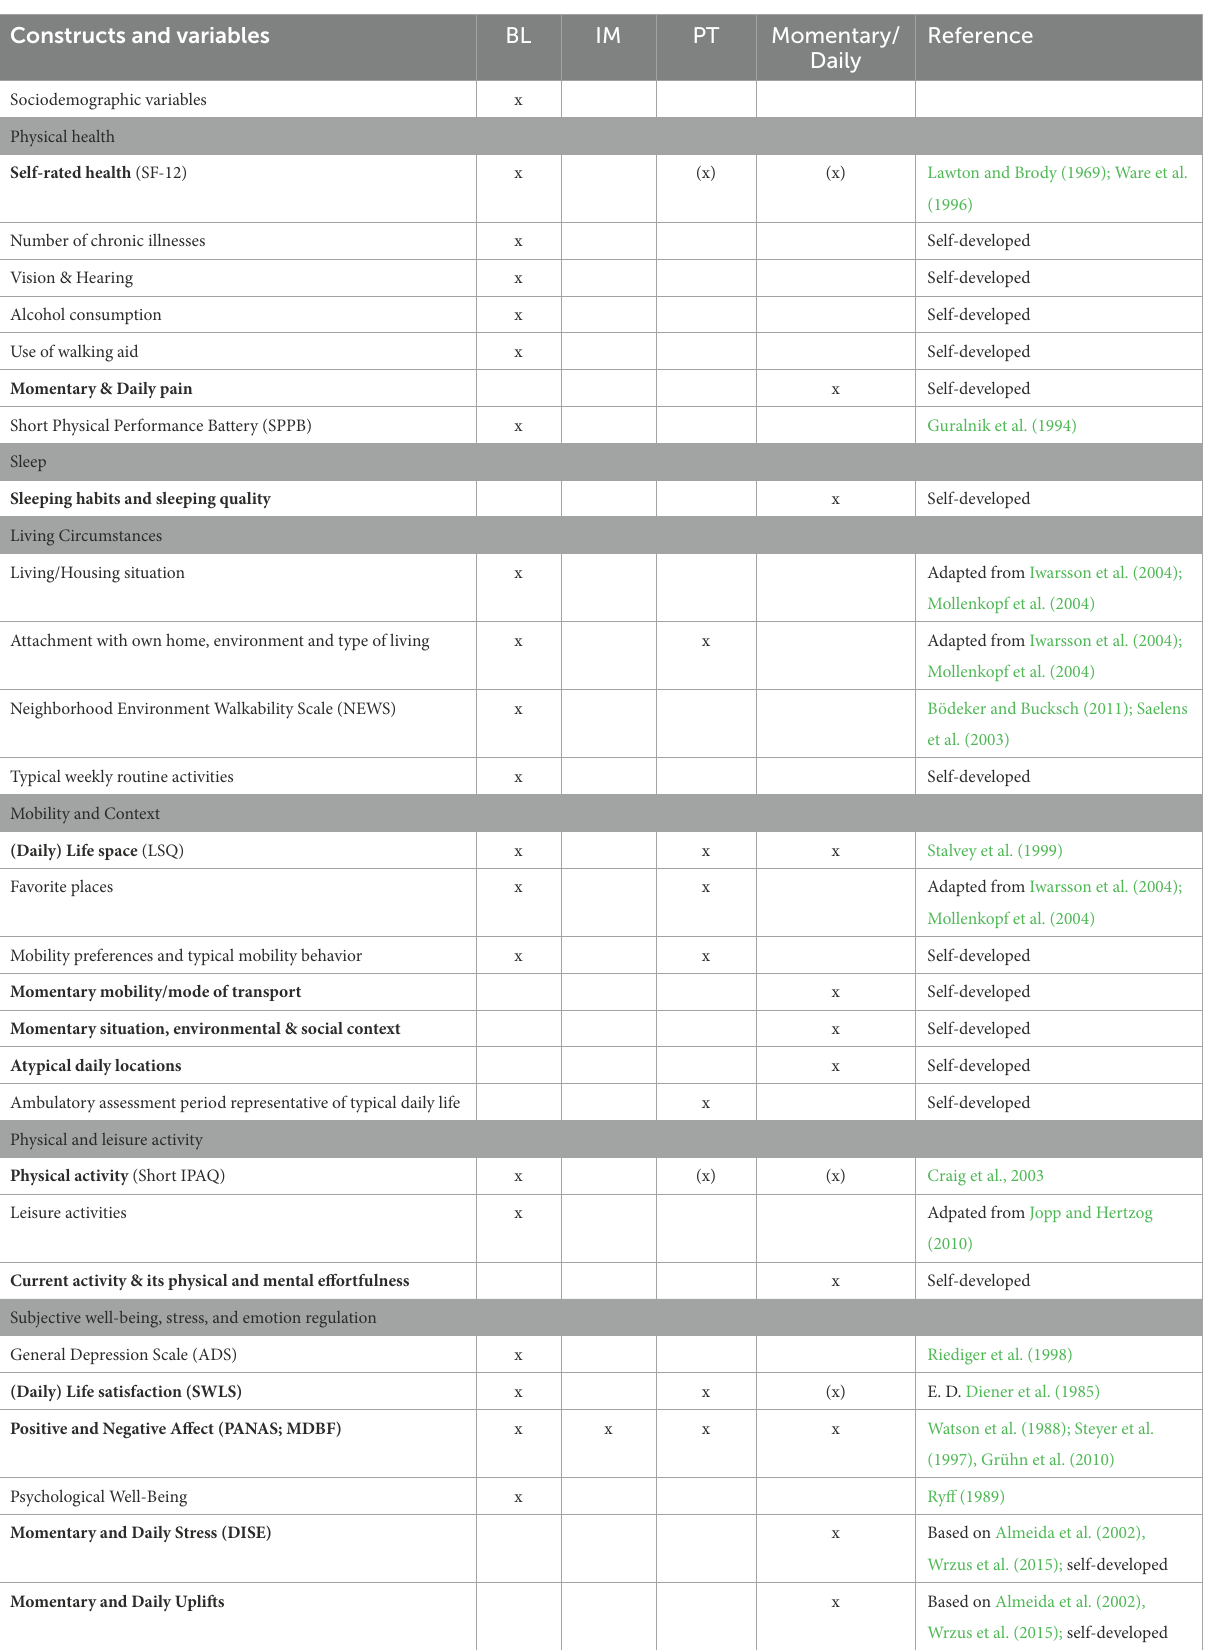
TABLE 2 Questionnaire measures and laboratory tasks across